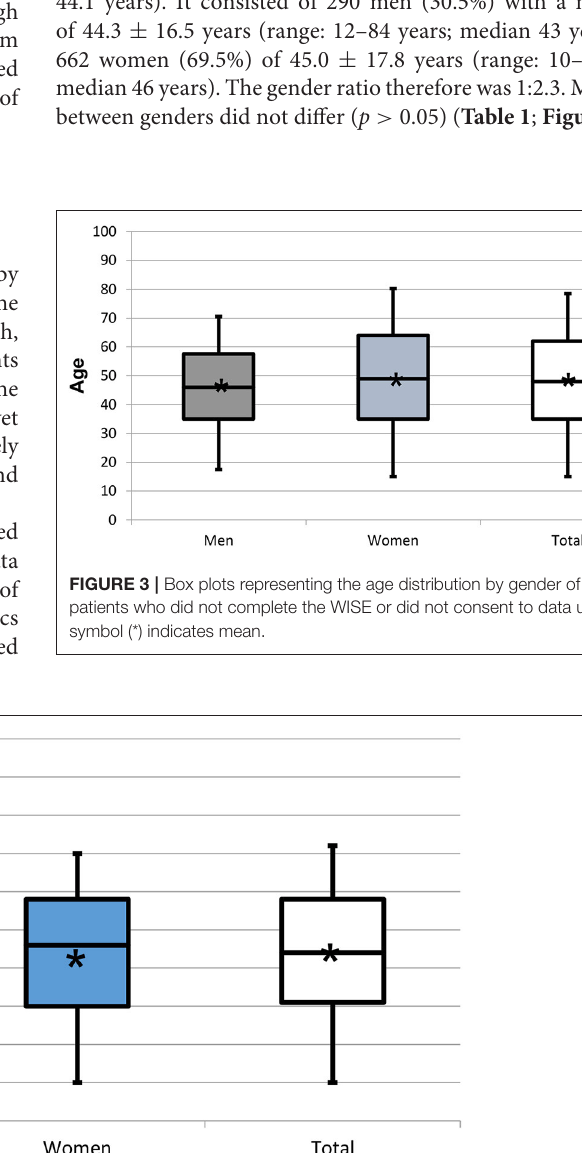
Frontiers in Neurology |